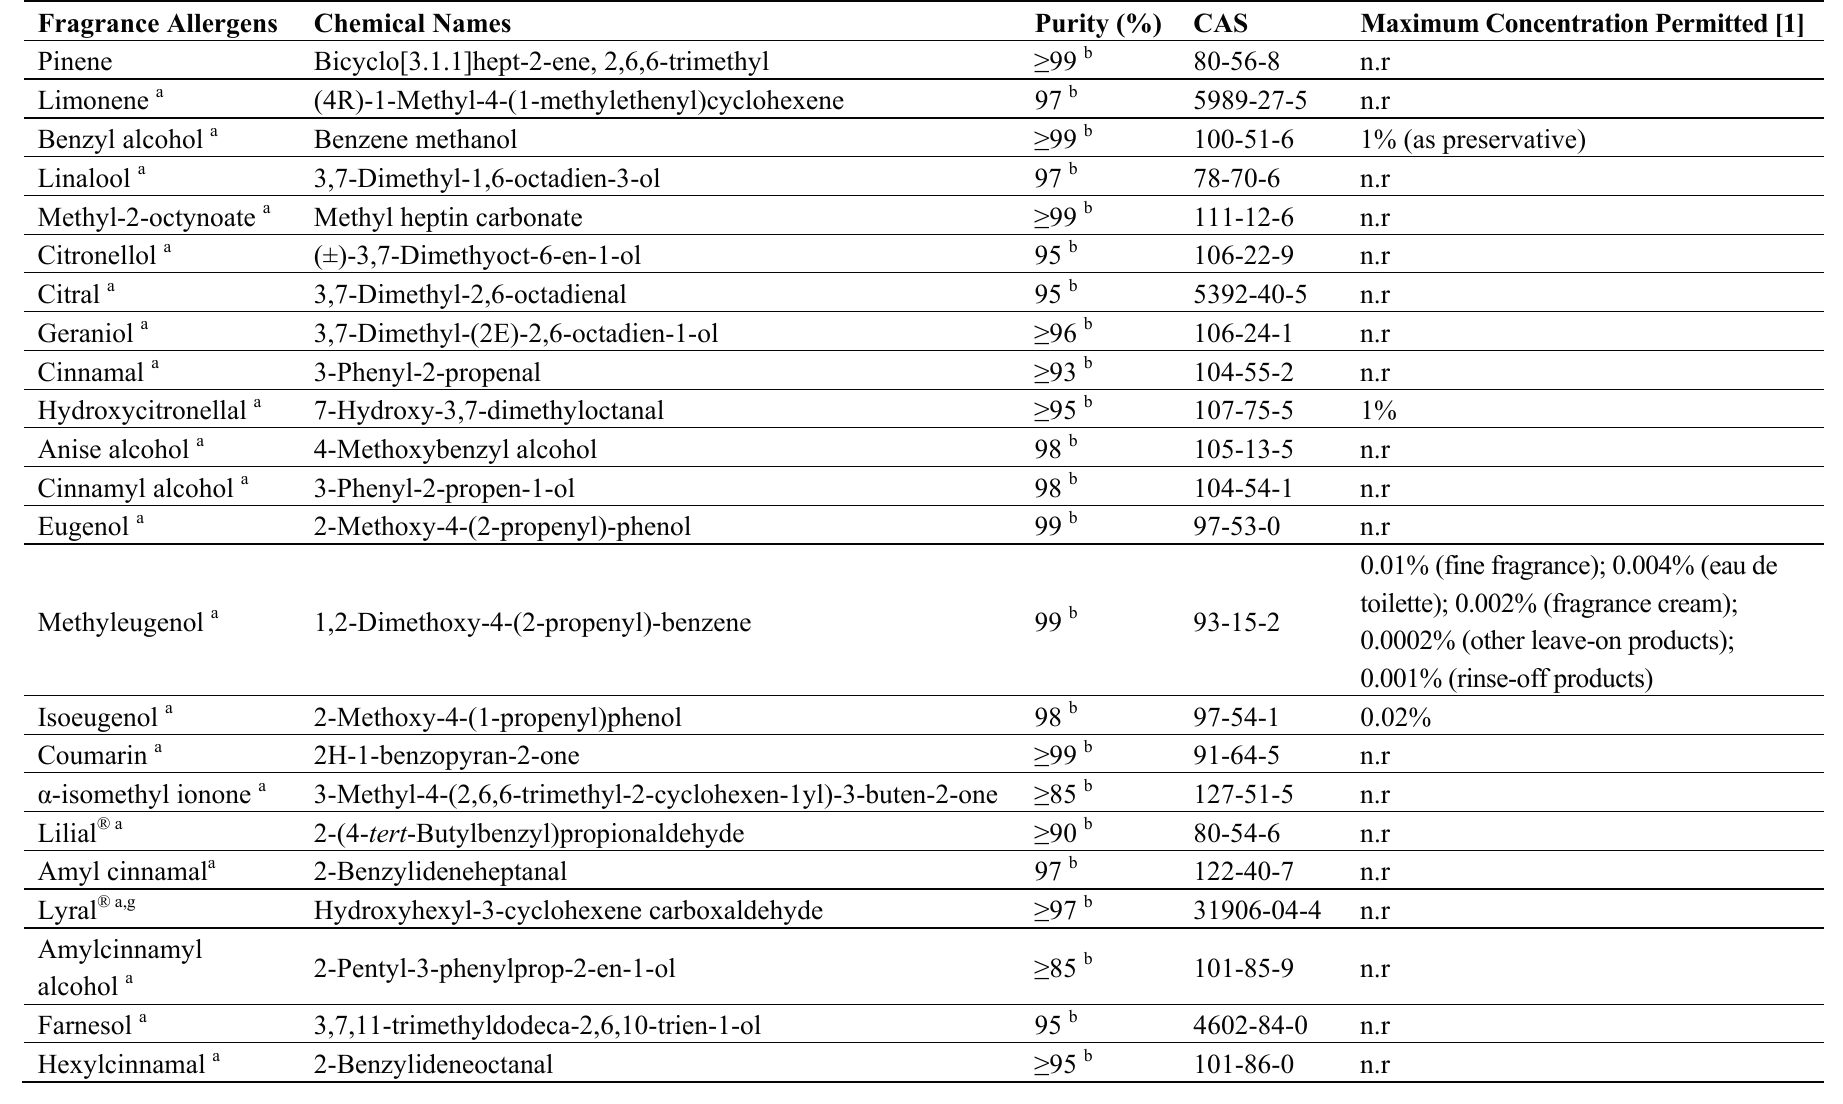
Table 1. Target compounds: chemical names, suppliers, purity, CAS and European